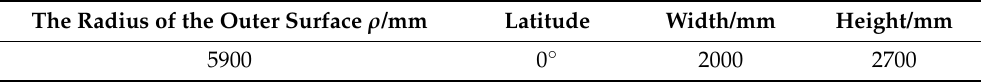
Table 2. The position and size of the component and a specific hole.